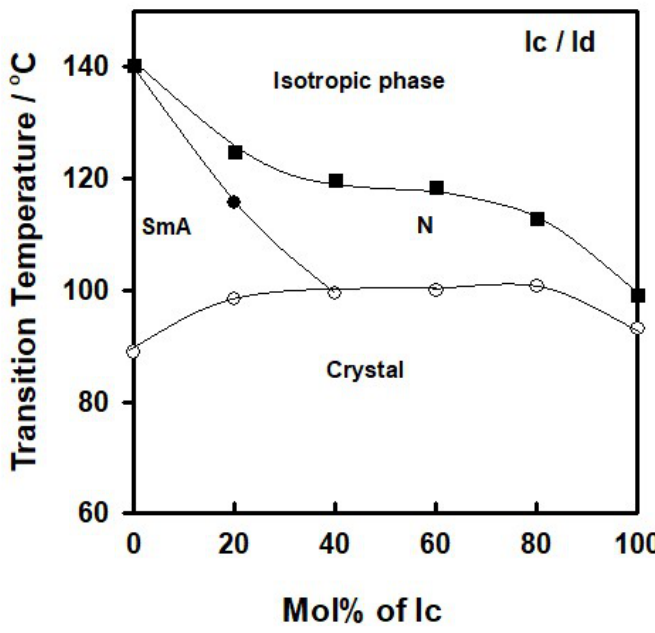
Figure 5. Binary phase diagrams for system Ic/Id; the symbol “o” denotes the solid–SmA phase, “●” the SmA–N phase transitions, and “ ■ ” is the N–I phase transition upon the second heating.